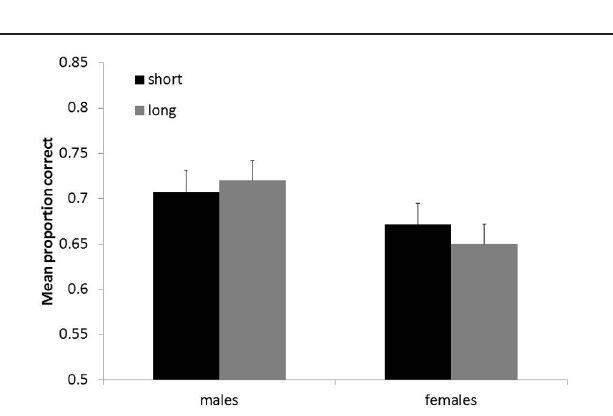
FIGURE 5 | Mean proportion correct trials ( + SEM) in the Position task for males and females.